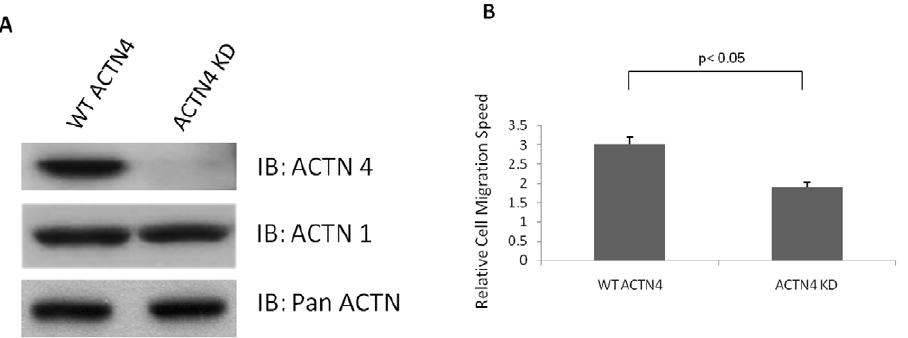
Figure 1. Knockdown of ACTN4 impairs cell migration of murine lung fibroblasts. (A) WT ACTN4 and ACTN4 KD murine lung fibroblasts grown in 6-well Petri-dish plates were lysed with RIPA buffer in the presence of 1 6 proteinase cocktail mix. Equal amount of total protein were separated by 7.5% SDS-PAGE and immunoblotted with anti-ACTN4, ACTN1 and pan-ACTN. The data are representative of three independent experiments. (B) Cells were plated on 6-well plastic dishes and grown to confluence in DMEM in the presence 10% fetal bovine serum. A scraped area was made by a rubber policeman and then cultured for additional 24 hr. Photographs were taken at 0 hr and 24 hr, and the relative distance migrated by the cells was determined by using Photoshop software. Data are mean 6 s.e.m., measured from three independent experiments each in triplicate.